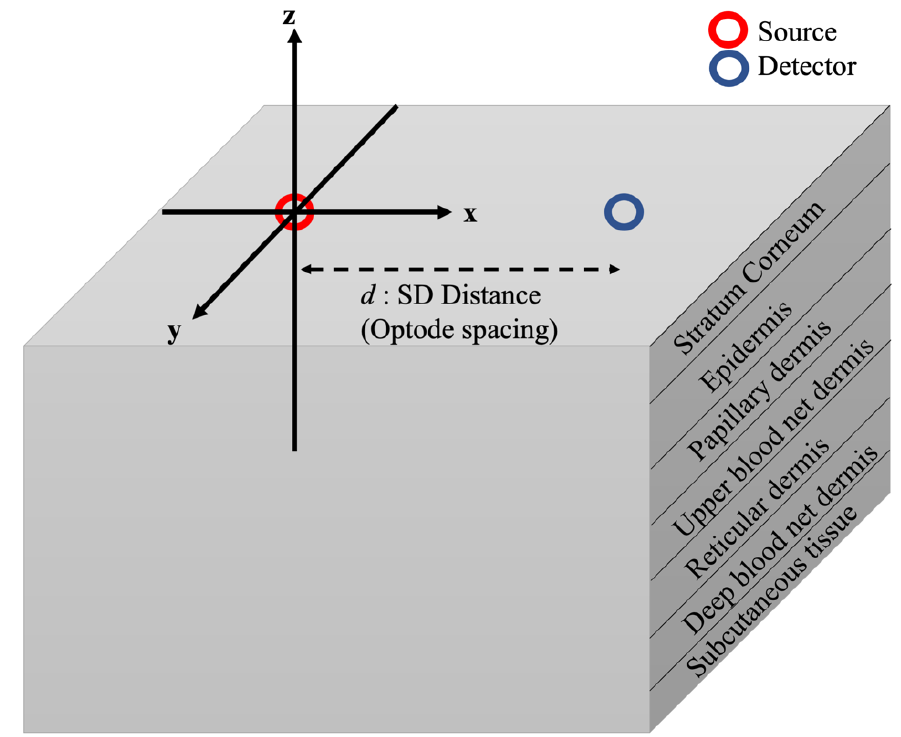
Figure 1. Illustration of the Monte Carlo model for human skin adopted in this study. The light source was placed at the center (0,0,0) of the model, and the detector was placed at a distance ( d ,0,0) away from the source.